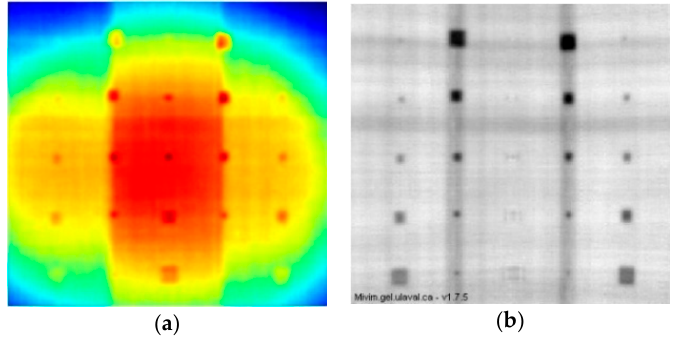
Figure 3. ( a ) Raw thermal image of the inspected surface at t = 1.25 s after the application of the heating pulse; and ( b ) phase image of the inspected surface at f = 0.16 Hz.